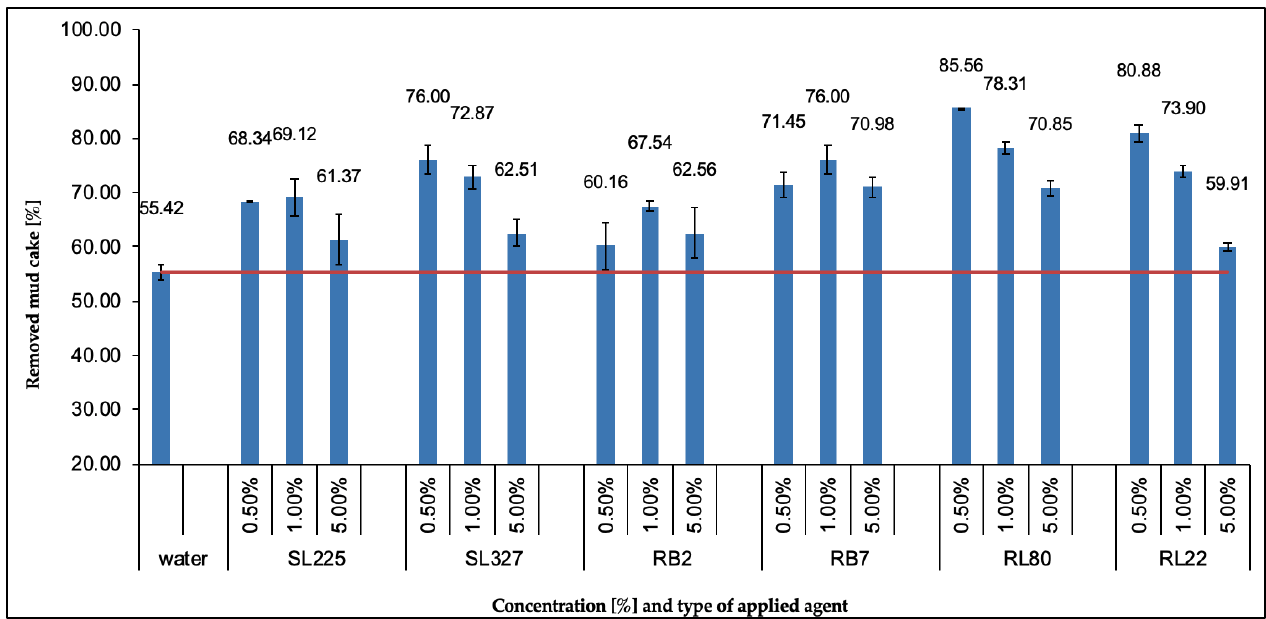
Figure 7. Efficiency of mud cake removal from the rotor’s surface with new fluids. The red line shows the reference value for water.